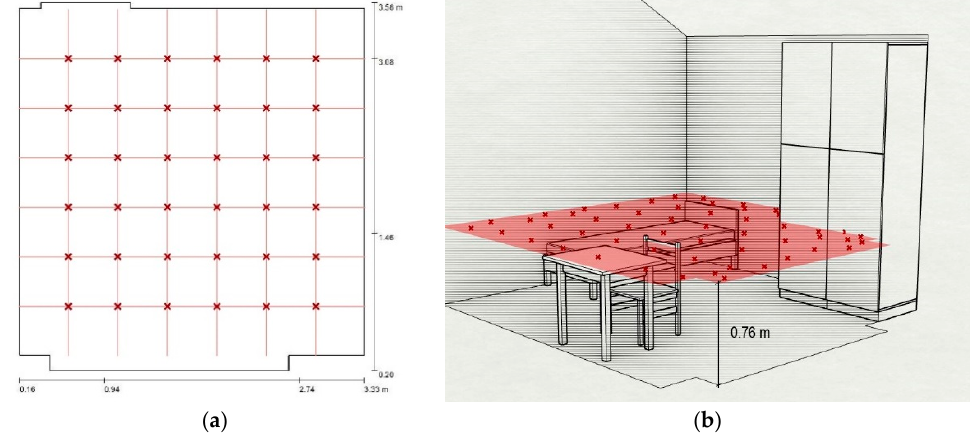
Figure 4. Grid for the evaluation of sDA and E m in Bedroom 3: ( a ) plan and ( b ) perspective view.